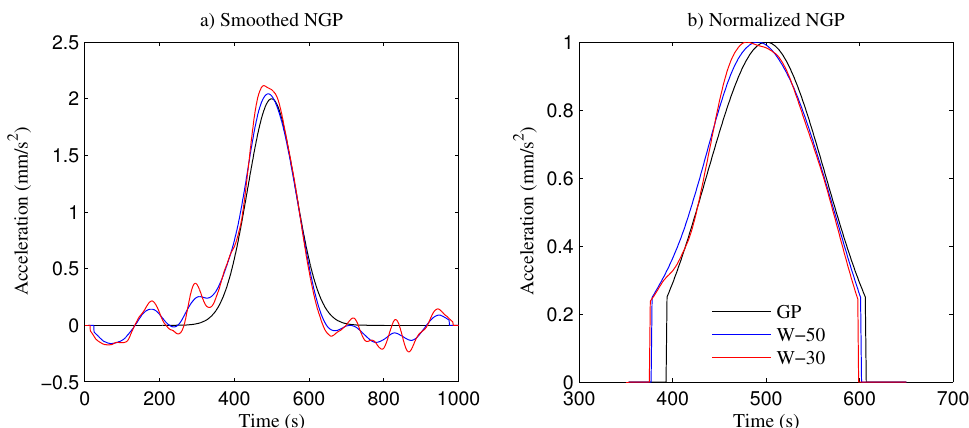
Figure 10. The phase shifts generated by the smoothing process: ( a ) signals after smoothing; ( b ) nor- malized and filtered peaks.